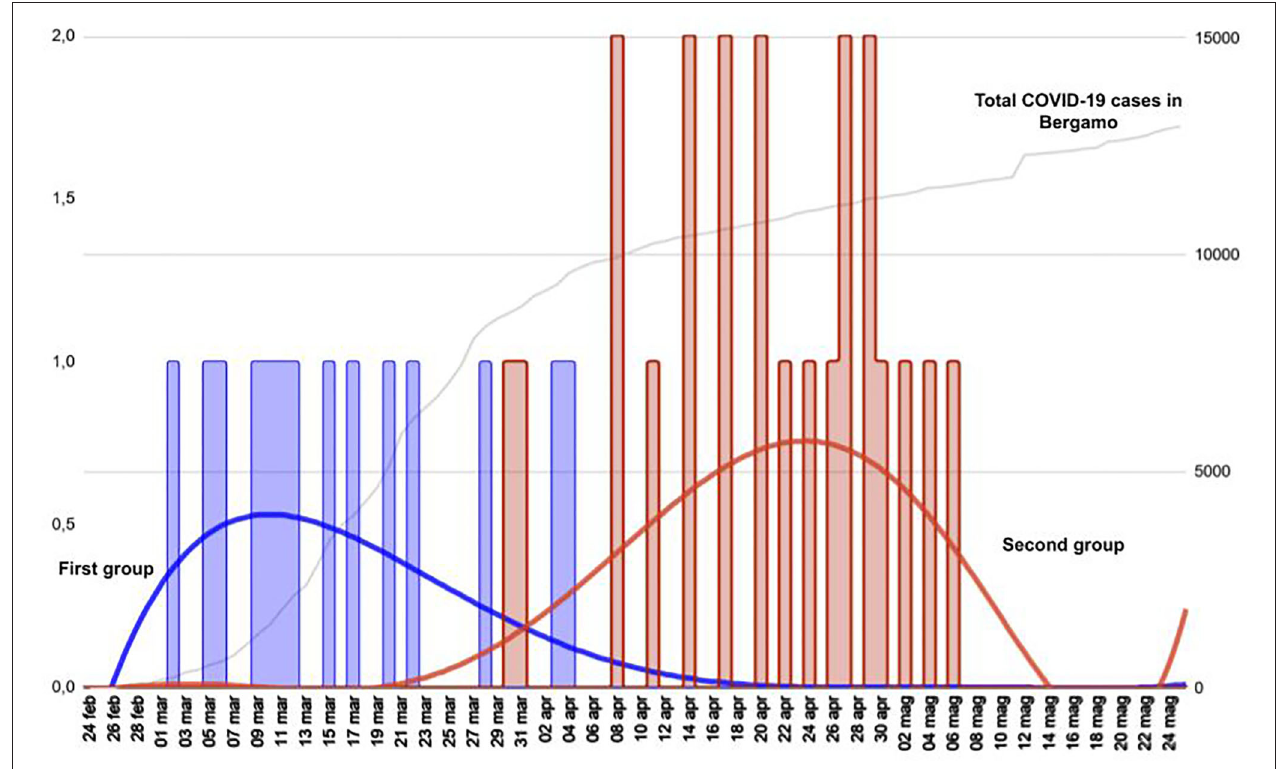
FIGURE 3 | Timeline distribution of cases of COVID-19 showing a clearly biphasic pattern of presentation. Total COVID-19 cases in Bergamo depicts the epidemic trend in the city. The first group comprises children with viral sepsis, pneumonia and influenza-like sdr, whereas the second group comprises patients with MIS-C and neurological